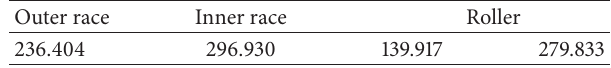
Table 3: Characteristic frequency of bearing Rexnord ZA-2115